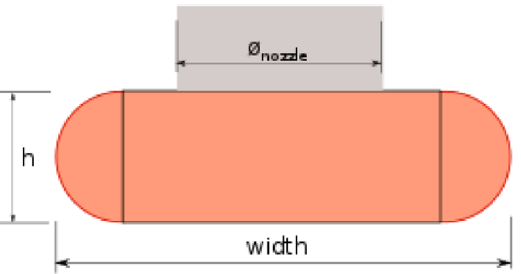
Figure 4. Extruded filament cross section showing the relationship between the desired extrusion width and volume to extrude. Reprinted from Slic3r Manual.